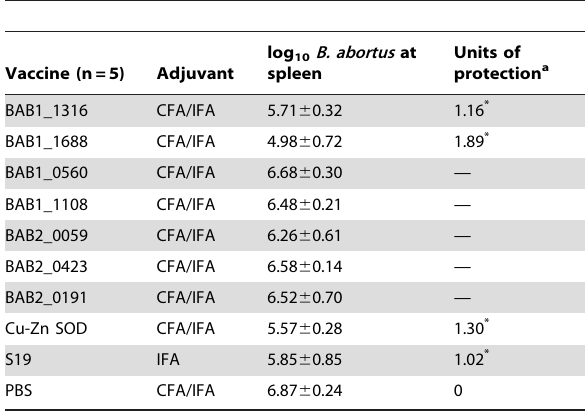
Table 2. Protection against B. abortus 544 infection induced by recombinant B. abortus proteins immunization.